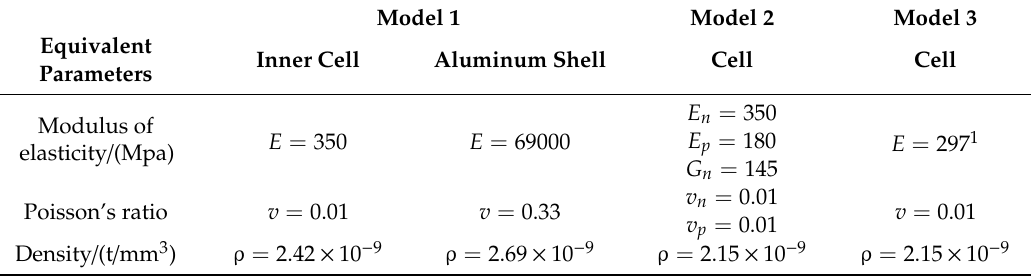
Table 4. Material parameters for Model 1, 2, and